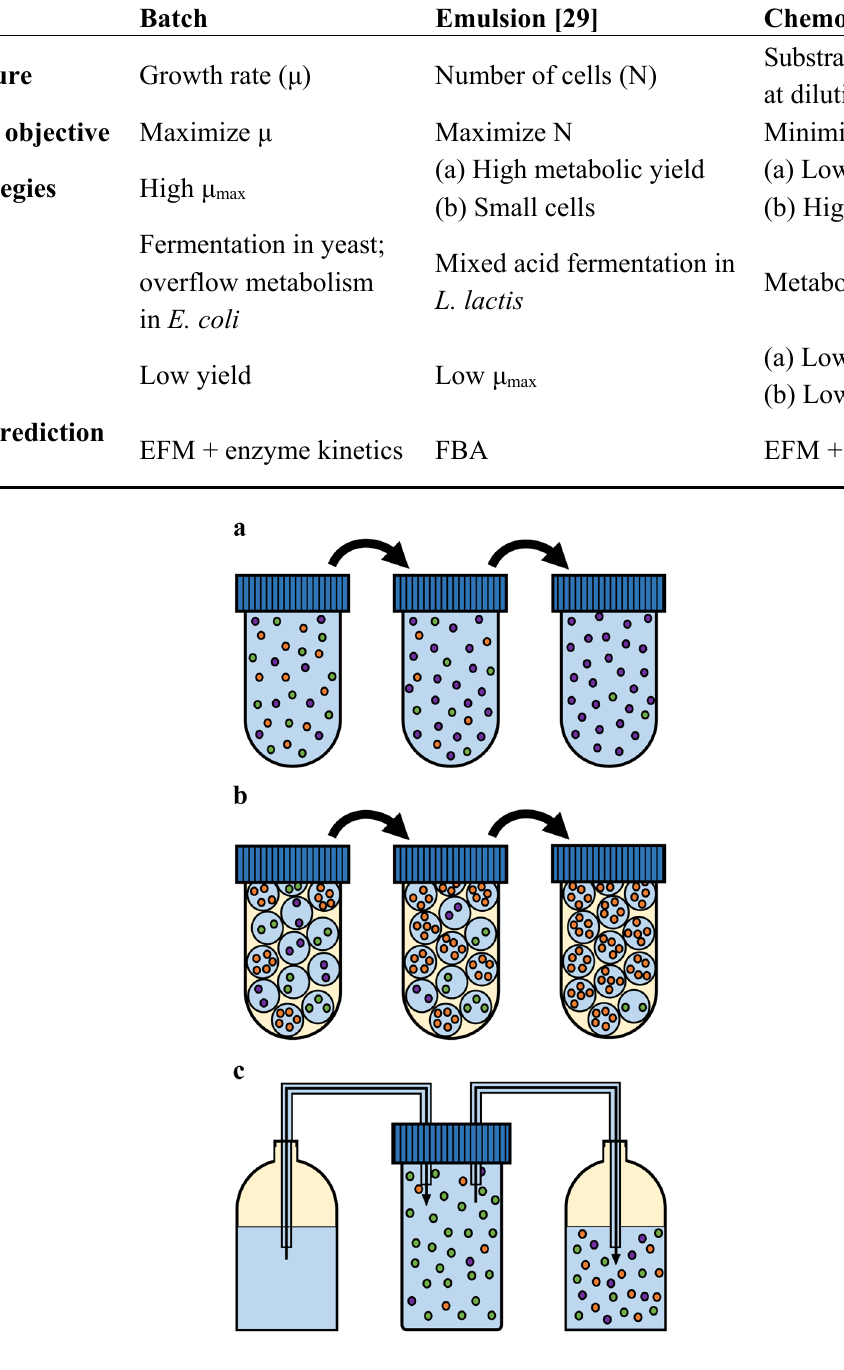
Figure 4. Culturing methods used in laboratory evolution experiments. ( a ) Serial propagation in batch, where after a certain period of growth in suspension, cells are diluted into fresh medium and the cycle is repeated; ( b ) Serial propagation in emulsion, where single cells are compartmentalized in a water-in-oil emulsion, thereby privatizing the resources. Each cell is now allowed to deplete the resources before the cells are mixed, diluted and a new emulsion is made. This cycle is subsequently repeated; ( c ) During chemostat culturing, a continuous inflow and outflow of medium ensure constant growth rate and conditions for the cell population. In all figures the different colours indicate different